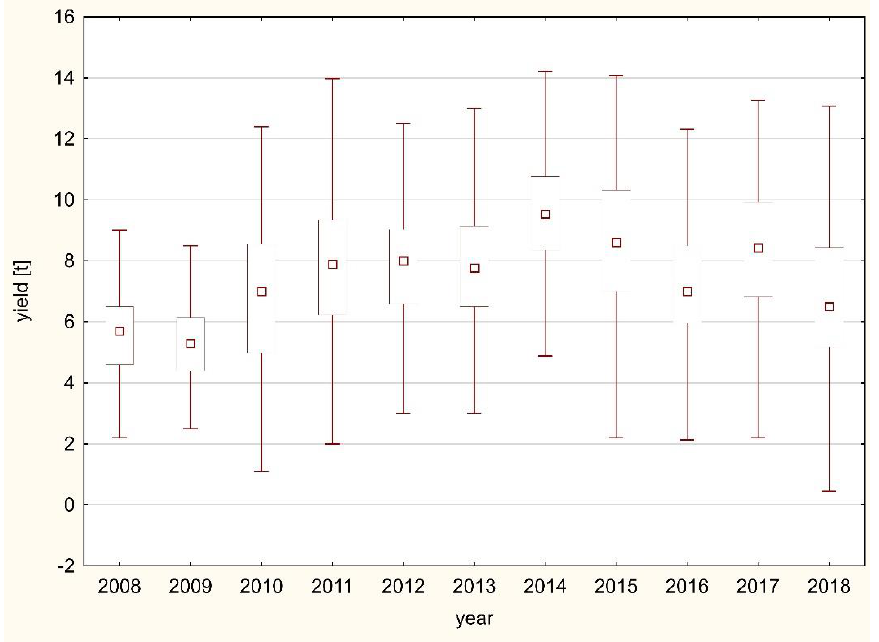
Figure 2. Temporal variability in yield within the 11 years for both commercial and experimental farms together. For each year, the middle is the median, the box is the first and third quartiles, and the whiskers are the minimum and maximum values. Table 2. Grain yield of winter wheat [t/ha] in each voivodeship in each studied year for both com- mercial and experimental farms together. Numbers of voivodeships are the same as in Figure 1. No.